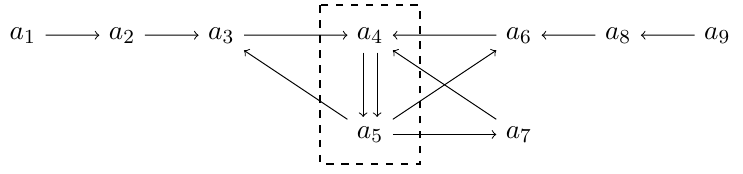
Figure 9 . Principal part of a certain cluster in Gr(4 ; 8). The a(cid:14)ne A (1) highlighted by the dashed